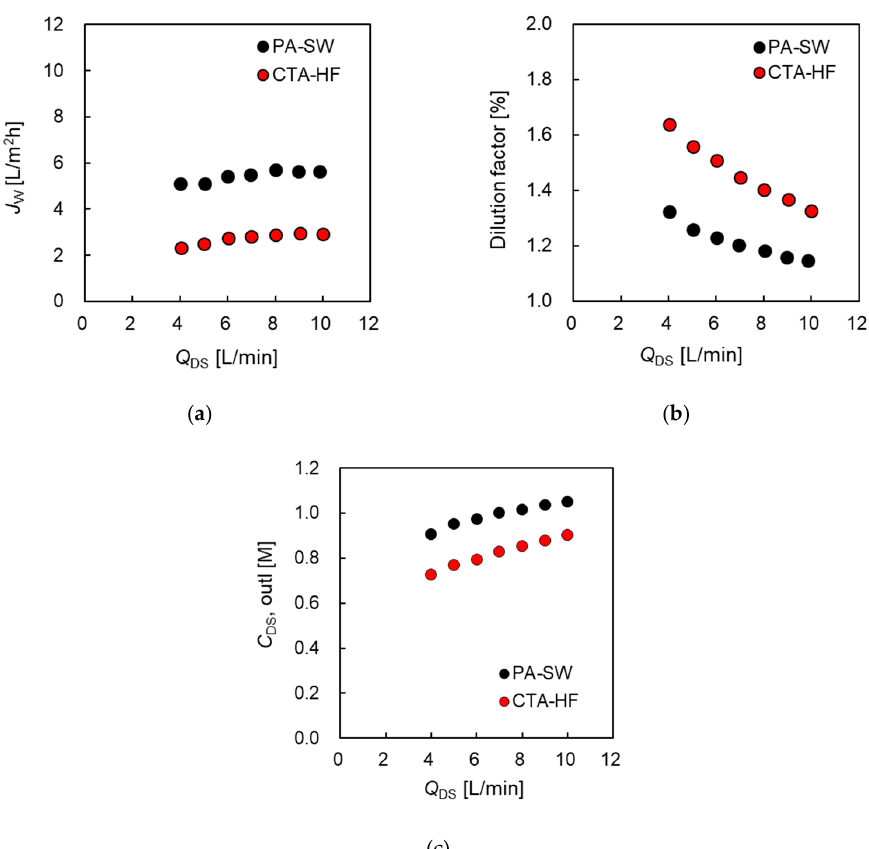
Figure 7. ( a ) Water flux, J w , and ( b ) dilution factor, φ , and ( c ) the concentration of the module outlet at DS side ( C DS,out ), respectively, as a function of DS flow rate, Q DS . DS: 1.2 M NaCl. FS: treated tap water. Q FS : 5.0 L/min. Δ P : 1.6 MPa for PA-SW module and 2.5 MPa for CTA-HF module.